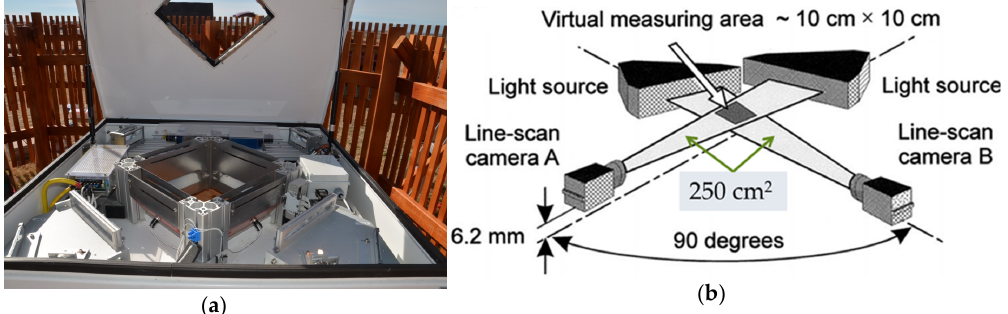
Figure 8. ( a ) Two-dimensional video disdrometer (2DVD), SN36 model; ( b ) Schematic showing the